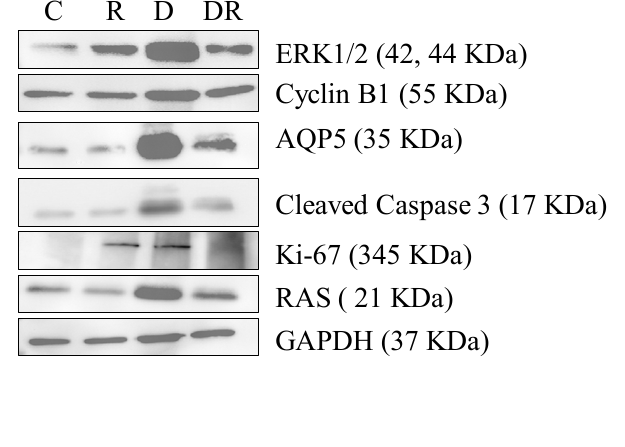
molecule through its interactions with hyaluronan and cytoskeletal components in addition to maintaining tyrosine kinase activity [44]. The aberrant expression of CD44 in malignancy can lead to tumor extension and metastasis. We observed high CD44 expression in mice treated with 4 Gy radiation (241.18 ± 5.56), whereas weak CD44 expression was observed in the DMA (112.02 ± 5.37) and DMA + radiation (130.2 ± 6.32) groups, which was highly correlated with the morphological changes observed using AFM (Figure 6 E,F).